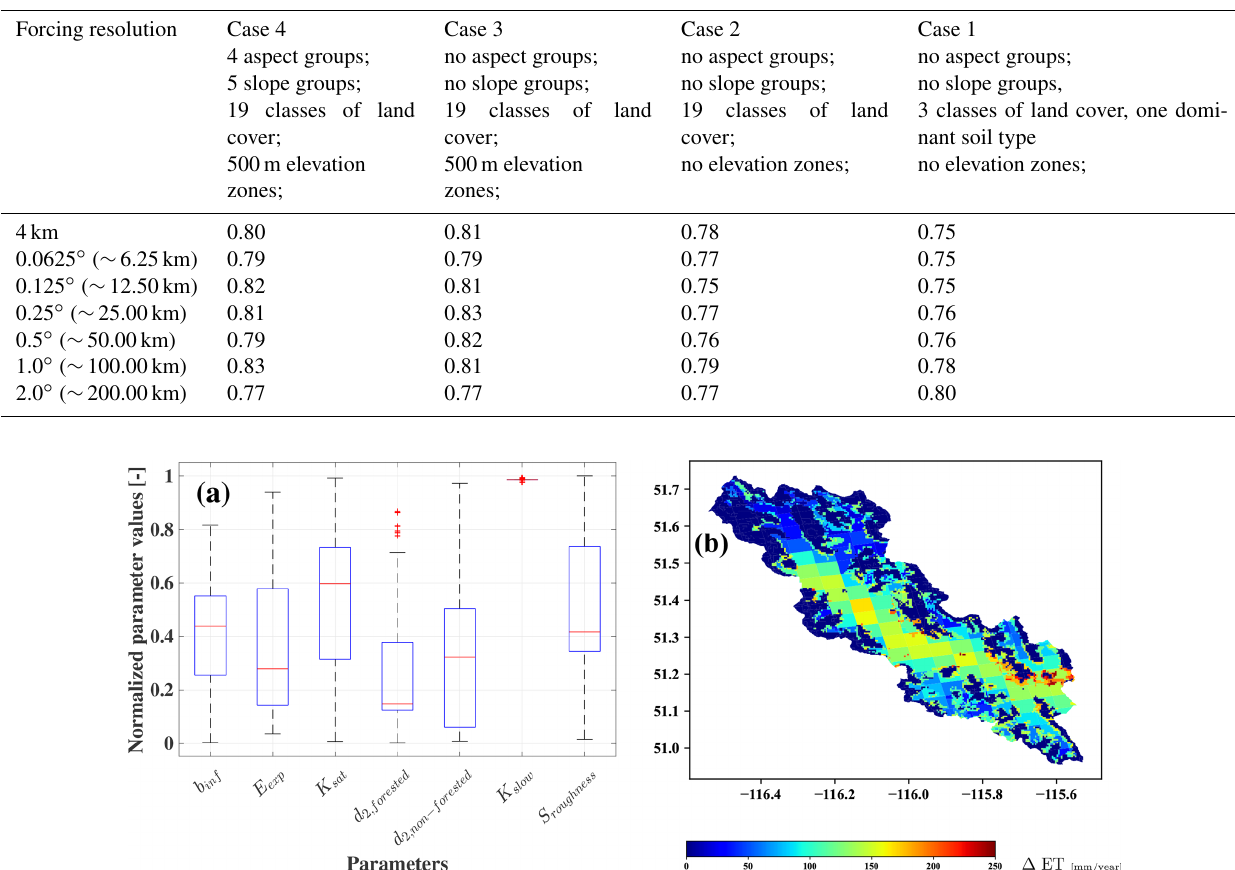
Table 3. The highest calibrated Nash–Sutcliffe performance metric ( E NS ) for the different model configurations. Details on the geospatial cases are provided in Table 2.